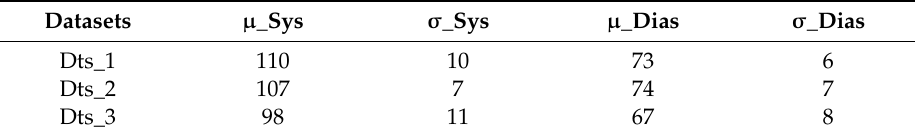
Table 3. Statistical summary of the generated datasets (Dts_i).